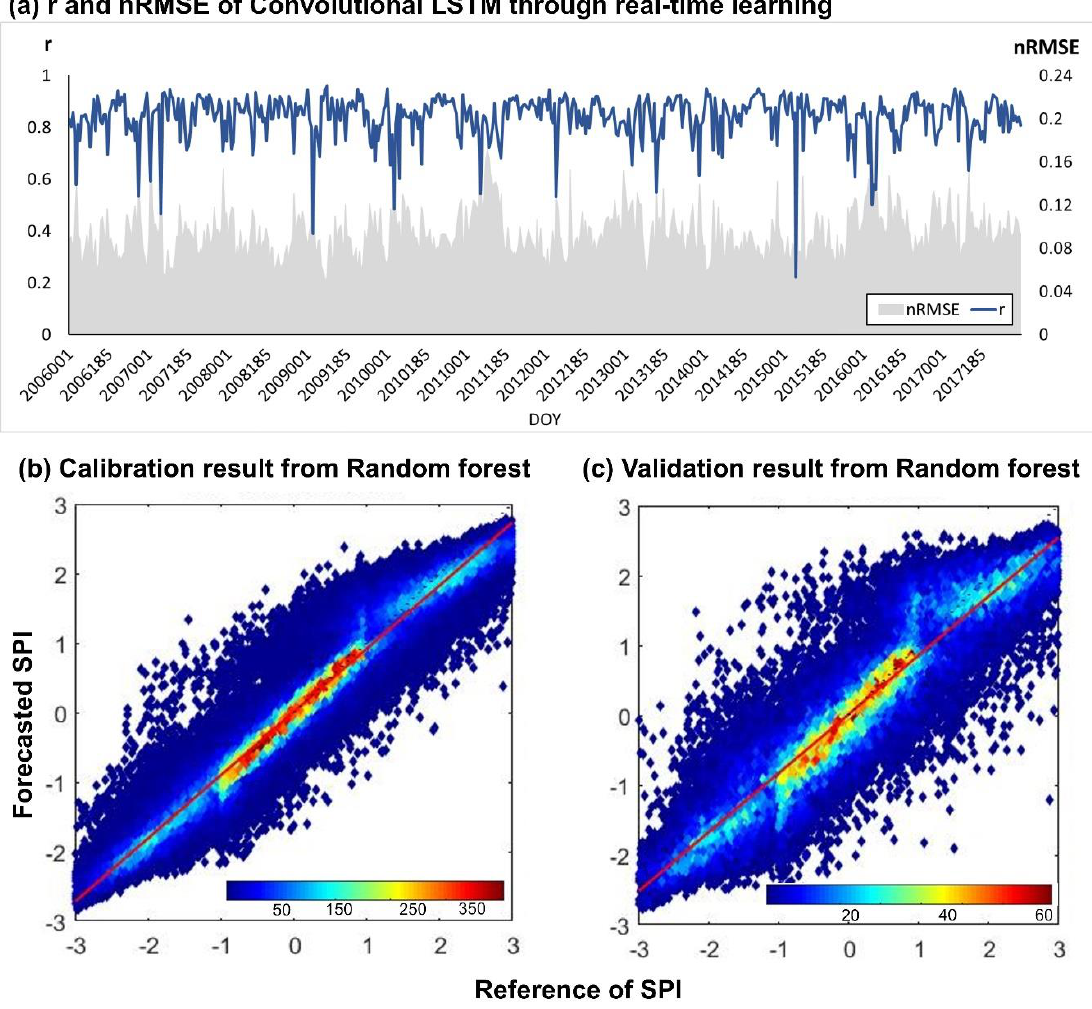
Figure 5. Results of step 1 and step 2 for SPI. ( a ) r (blue line) and RMSE (gray shading) through the real-time training of convolutional long short term memory (ConvLSTM) from 2006 to 2017, ( b ) calibration results from random forest (RF), and ( c ) validation results from random forest (RF).